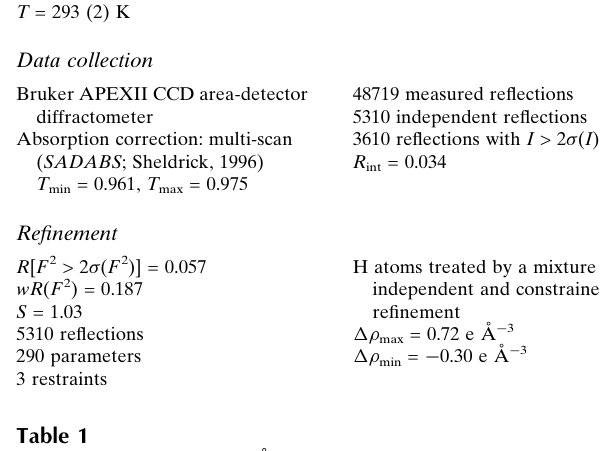
Hydrogen-bond geometry (A˚ , (cid:3)